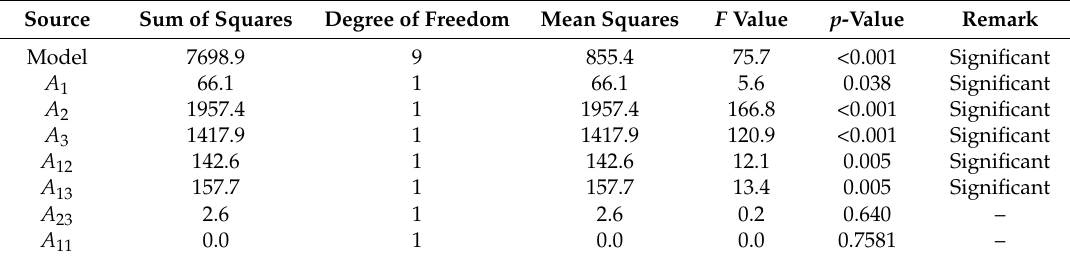
Table 3. ANOVA for the response surface quadratic